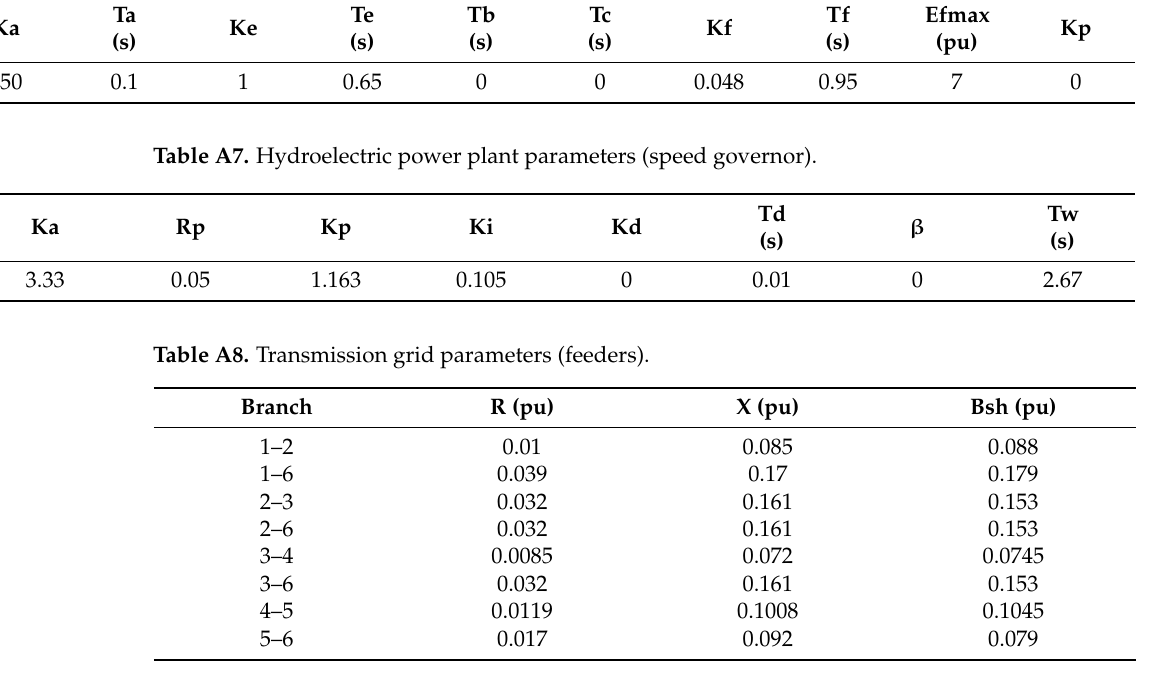
Table A9. Transmission grid parameters (transformers).